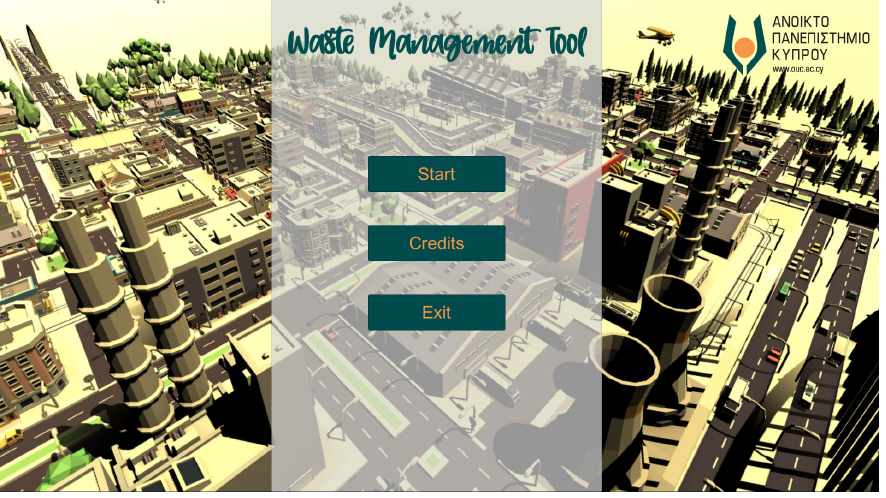
Figure 6. The Waste Management Tool’s main menu allows players to start the simulator, view the credits, or exit the game.